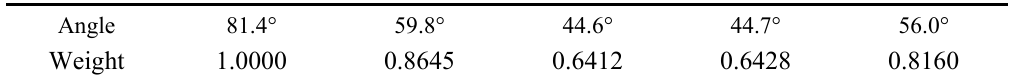
Table 5. Weight of each angle image for the ANGW method in the simulation image data experiment.